Question: Describe this figure in one sentence.
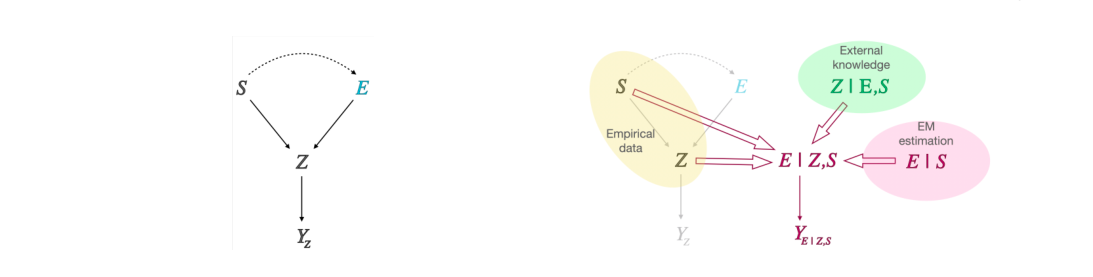
Answer: Left: illustration of the causal relation between the data. Right: illustration of our pre-processing method.